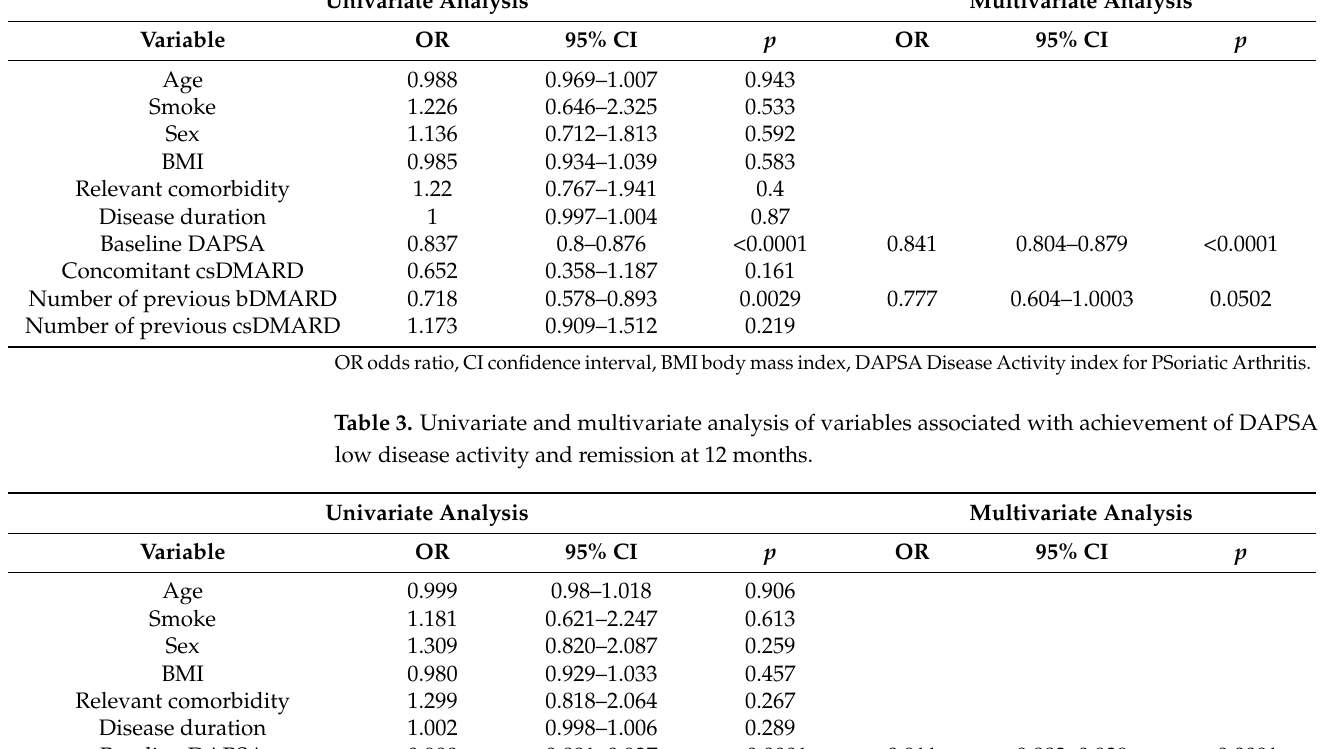
Table 2. Univariate and multivariate analysis of variables associated with achievement of DAPSA low disease activity and remission at 6 months. Univariate Analysis Multivariate Analysis